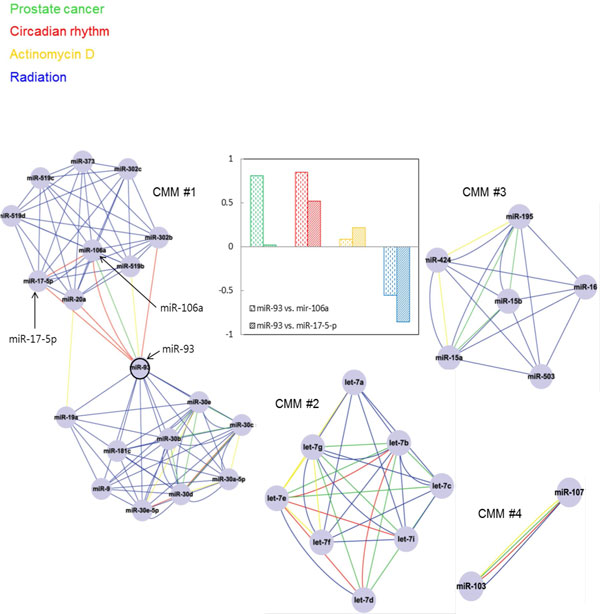
One miRNA participating in multiple condition specificity. The four representative CMMs identified with MCODE. The layout of this network was produced with Cytoscape [48]. Expression profiles of miR-93 and its partner miRNAs according to different conditions show correlation patterns.